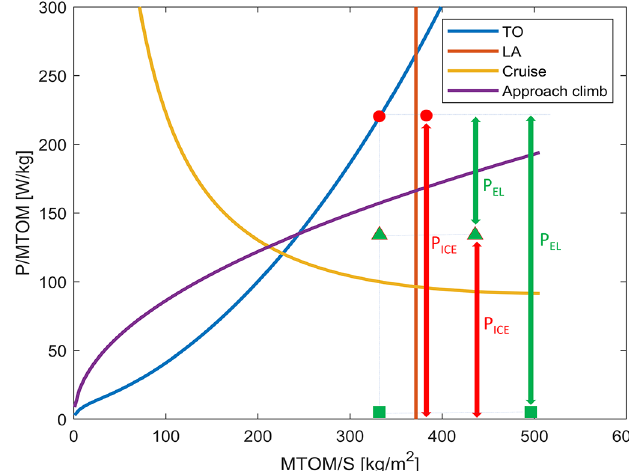
Fig. 4. Example of matching chart of speci fi c power versus wing loading. The green region is the feasible design space. Fig. 5. Repartition of electric and thermal power for a thermal propulsion aircraft ( * ), HEA ( ▴ ) and full-electric ( ▪ ) with a parallel